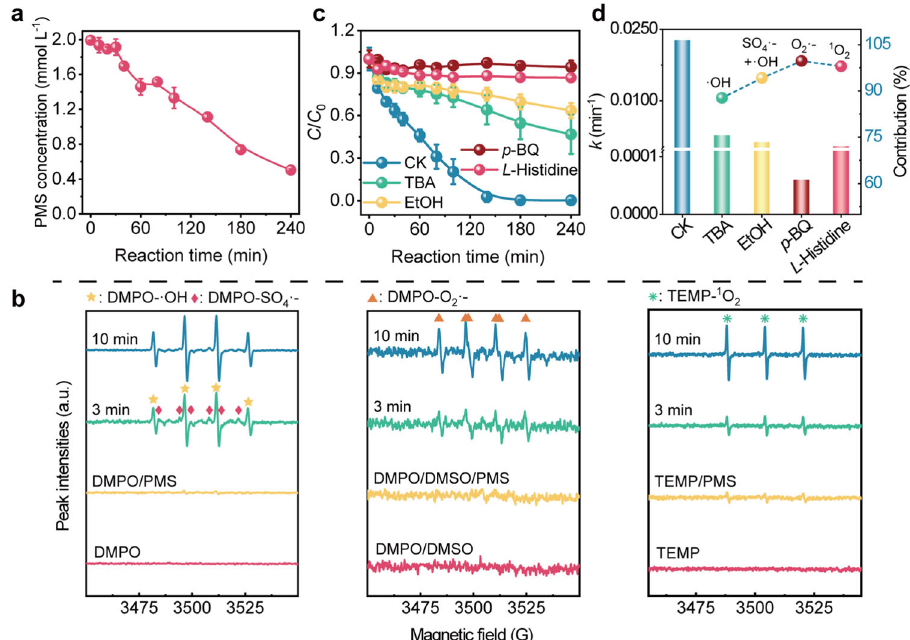
Fig. 3 Determination and contribution of reactive oxygen species (ROS). a The reducing concentrations of peroxymonosulfate (PMS). b Electron paramagnetic resonance (EPR) spectroscopy signal of ROS. c Degradation kinetics of bisphenol A (BPA) in the presence of quenchers. d The reaction rate constant of BPA based on pseudo- fi rst-order kinetics fi tting in the presence of quenchers, and the respective contribution of ROS to BPA degradation. The error bars represent the standard deviation (SD). Conditions: Mo 2 C MXene = 0.5 g L − 1